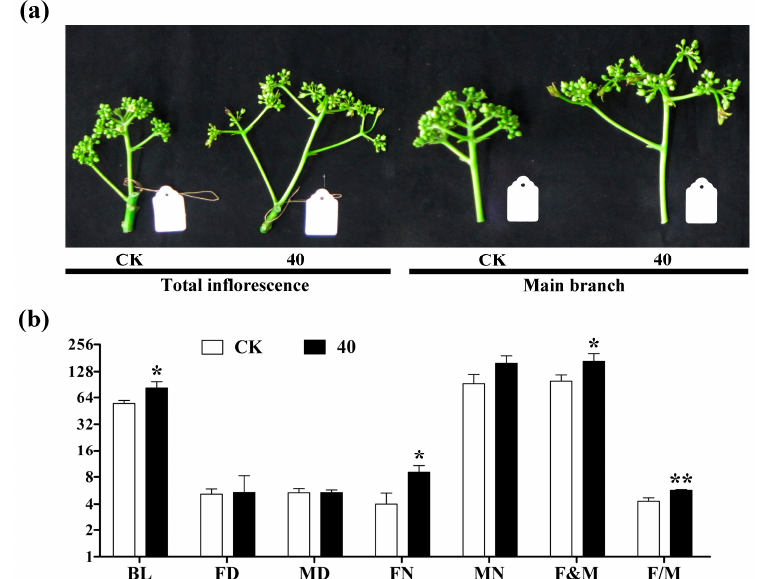
Figure 1. The morphology and statistics of the investigated traits after GA 3 treatment in J. curcas . ( a ) the morphology of the inflorescence after GA 3 treatment at 22 days, CK (control check) was treated by distilled water and 40 was treated by 40 mg/L GA 3 ; ( b ) the statistics of the investigated traits after GA 3 treatment at 22 days, BL was the length of the inflorescence, FD was the diameter of female flower, MD was the diameter of male flower, FN was the number of female flower, MN was the number of male flower, F&M was the total number of female and male flowers, F/M was the ratio of female to male flowers. The error bar means S.D., which was calculated by fifteen inflorescence meristems after the GA 3 and control treatment, respectively. * is significant difference ( p < 0.05), ** is very significant difference ( p < 0.01).